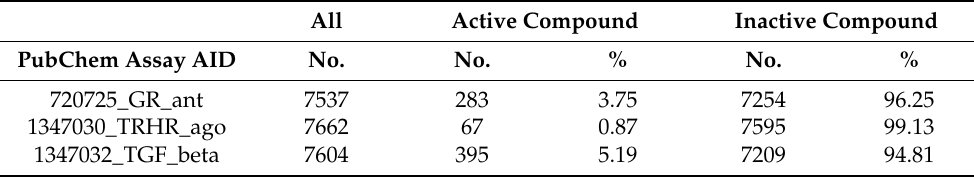
Table 6. Active and inactive chemical compounds of the three MIE targets. All Active Compound Inactive Compound PubChem Assay